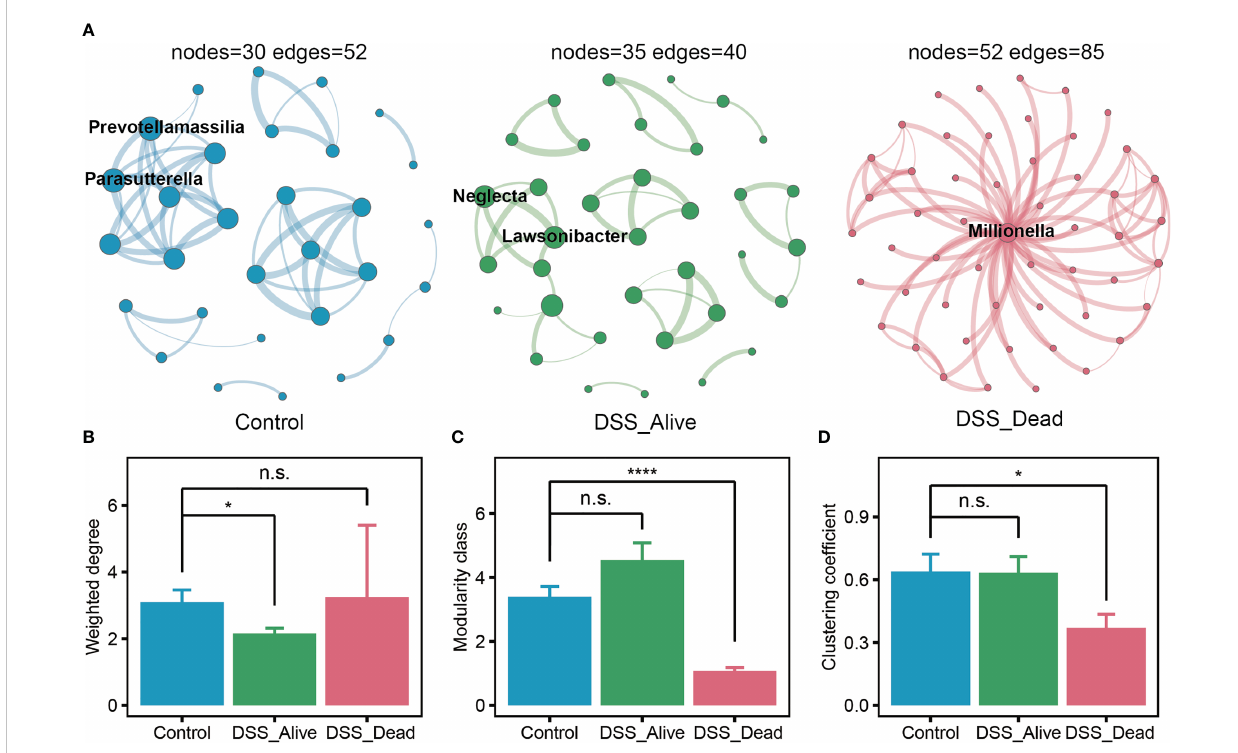
FIGURE 4 Co-occurrence network of the three group. (A) Microbial networks of Control group, DSS_Alive group, and DSS_Dead group. The size of the nodes was proportional to the value of the degree. The thickness of the edges was proportional to the degree of correlation. The properties of network about weighted degree, modularity and clustering coef fi cient present in (B – D) . n.s. means no signi fi cant difference, * means P < 0.05, **** means P <